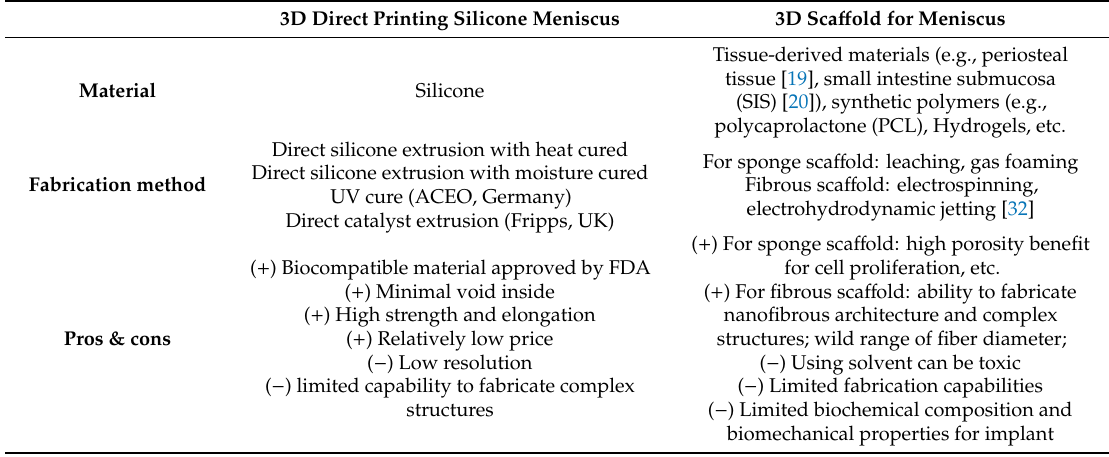
Table 3. Comparison of direct silicone print with 3D sca ff old for